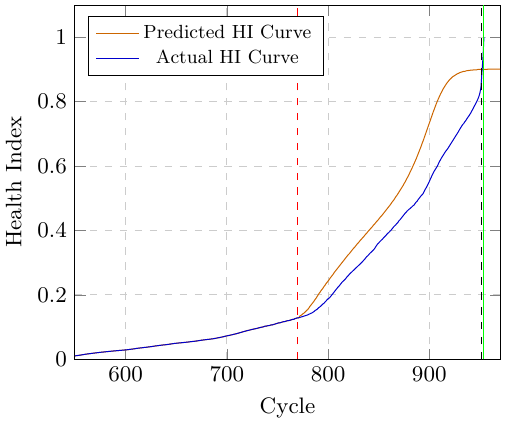
Figure 6. RUL prediction with training